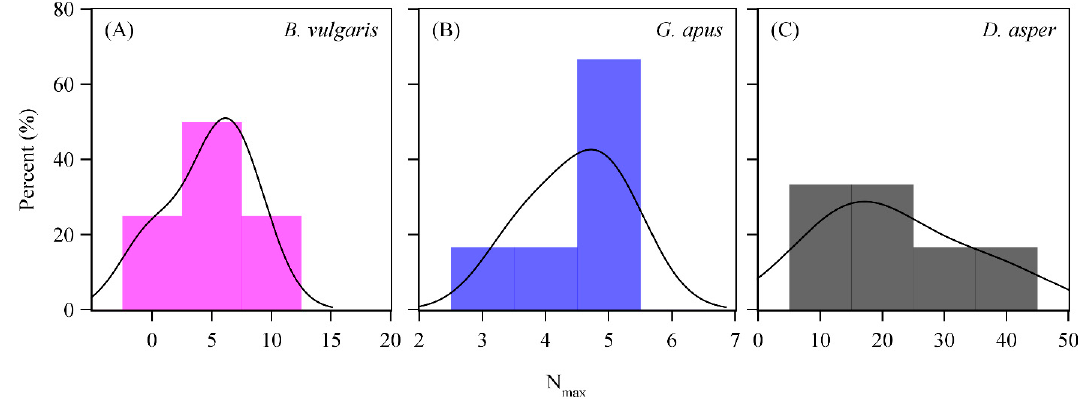
Figure 5. The distribution of the maximum amount of neighbor culms ( N max ) which may receive transferred water from the labeled culms ( B. vulgaris , G. apus, and D. asper ). Data of four established and four freshly sprouted culms were used for B. vulgaris , while three established and three freshly sprouted culms were used for G. apus and D. asper . The black lines represented fitted kernel distributions.